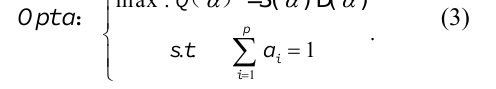
. Given the obtained optimal direction and the pro- jection index, an alysis of u nknown nodes d epends on simple matrix calculation. (V) Visualized Clustering